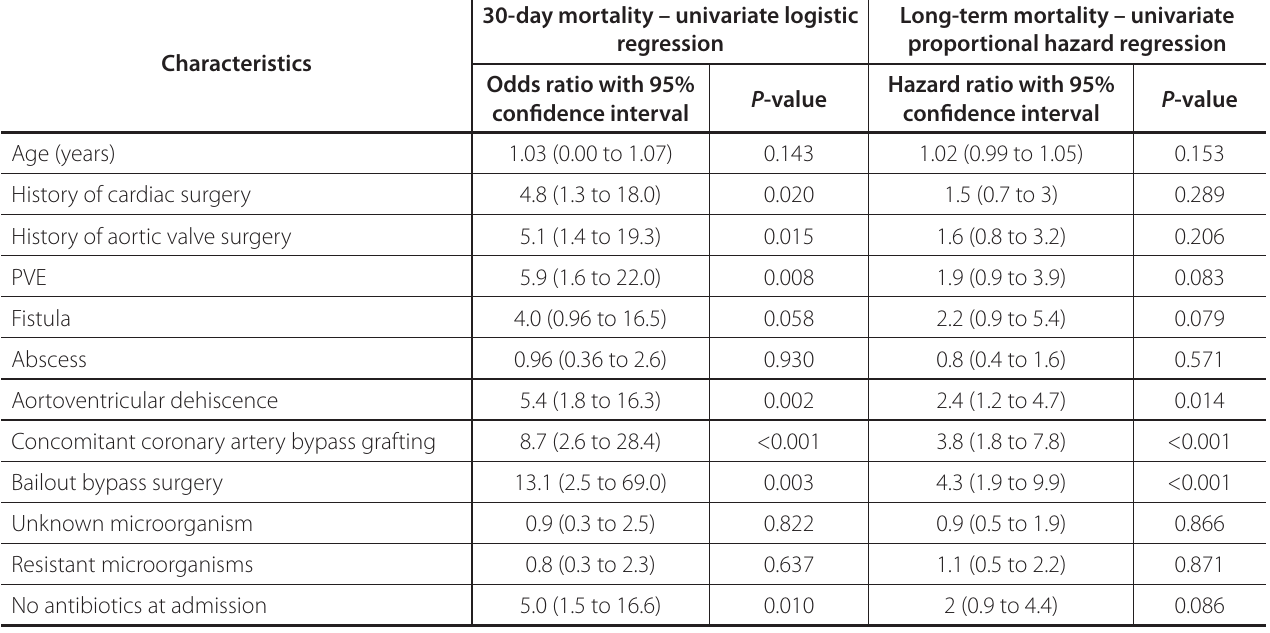
Fig. 2 - Cumulative freedom from composite endpoint (stroke, aortic valve reinfection, and aortic valve reoperation for any cause) within all three analyzed groups. Comparison with log-rank test, generally (P=0.024) and pairwise: native valve endocarditis (NVE) vs. early-onset prosthetic valve endocarditis (PVE) (P=0.008), NVE vs. late-onset PVE (P=0.013), and late- vs. early-onset PVE Table 5 . Independent risk factors of mortality